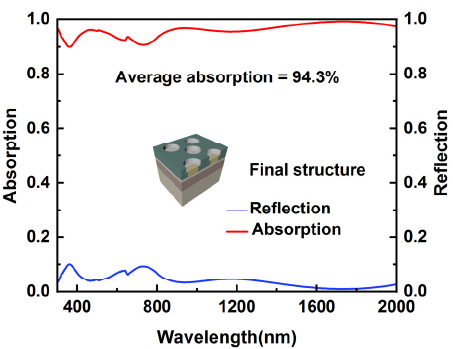
Figure 10. Absorptive and reflective spectra of the absorber at normal incidence. Table 3. Comparison between the different absorber designs proposed in previous studies. Refs.